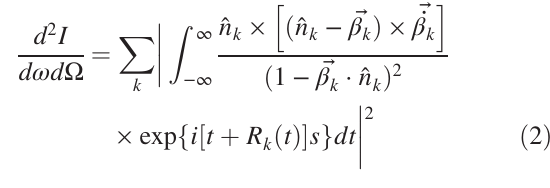
decomposed and v × B rotation is achieved correctly [38]. Boris algorithm is numerically stable and routinely used in standard particle-in-cell simulations. A separate module has been included in the existing MD code to study the radiation emitted by an accelerated charged particle. After calculating the trajectory of the particle [ r ð t Þ ; v ð t Þ ; _ v ð t Þ ] The energy radiated per unit solid angle per unit frequency can be calculated by Li´enard-Wiechert potentials and in normalized units is given by